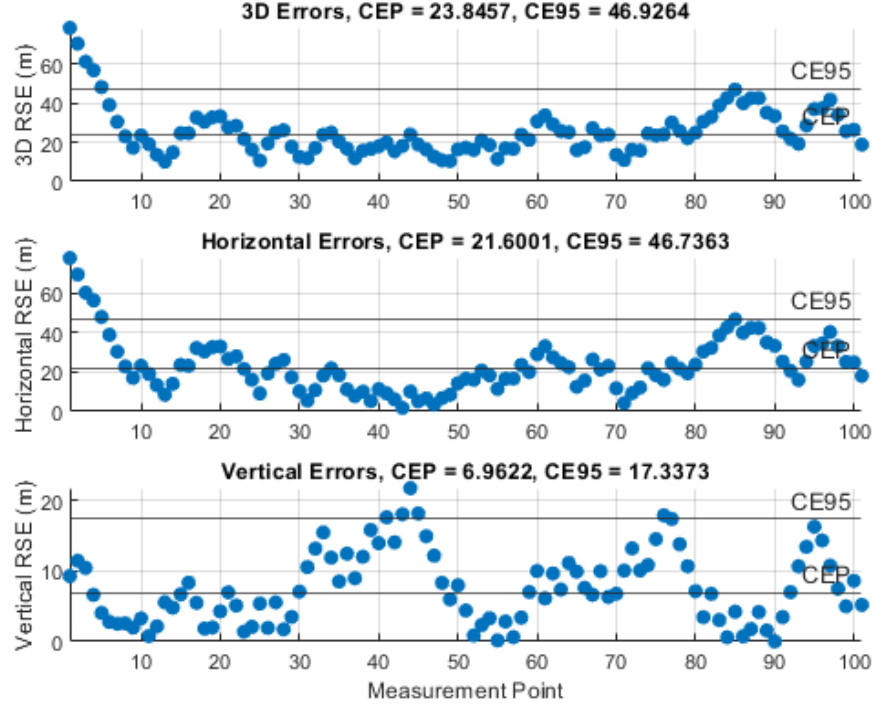
Figure 12. RSE evolution of the IPF solution with a measurement error SD, σ θ , ϕ , of 3 ◦.